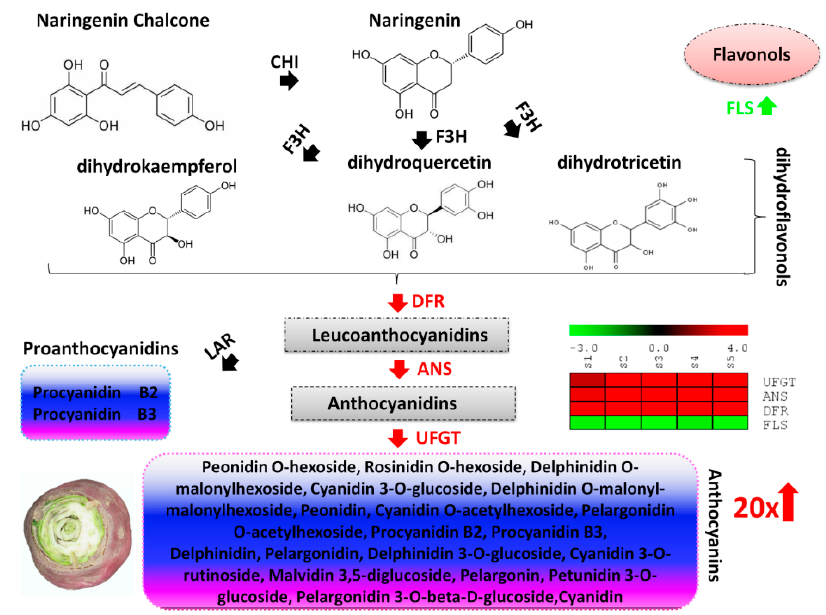
Figure 5. Proposed model of the molecular mechanism leading to the high anthocyanin content in the purple turnip (PT). Naringenin chalcone is isomerized by chalcone isomerase (CHI) to naringenin. Flavanone 3-hydroxylase (F3H) converts naringenin into dihydroflavonols (dihydrokaempferol, dihydroquercetin or dihydrotricetin). Then, the three dihydroflavonols are converted into colorless leucoanthocyanidins by dihydroflavonol 4-reductase (DFR) and subsequently to colored anthocyanidins by anthocyanidin synthase (ANS). Anthocyanidins are glycolsylated to facilitate their accumulation in cells by the enzyme flavonoid 3- O -glucosyltransferase (UFGT). Proanthocyanidins are generated by the action of leucoanthocyanidin reductase (LAR) from leucoanthocyanidins. DFR, ANS and UFGT were found significantly up-regulated in PT leading to a high content of 17 anthocyanins compounds (more than 20 times compared to the green turnip). In contrast, FLS was found significantly down-regulated and may lead to a weak accumulation of flavonols. PT tends to prioritize anthocyanins accumulation by diverting dihydroflavonols to the anthocyanins biosynthesis pathway.